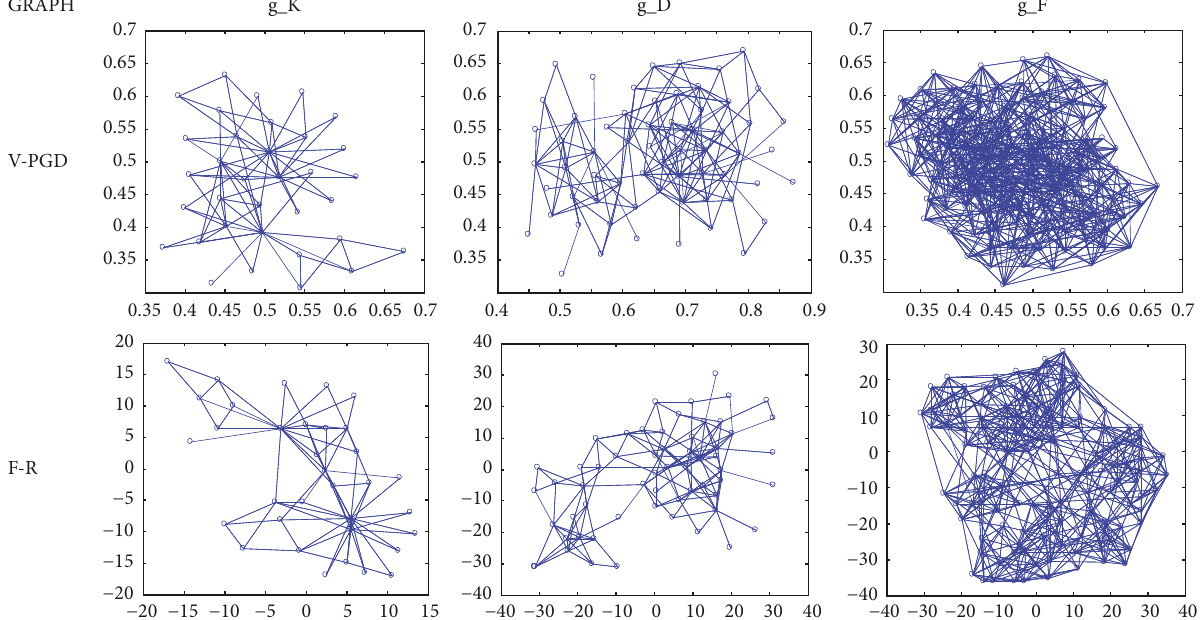
Figure 4: Drawings by V-PGD and by the F-R method on 3 real graphs.